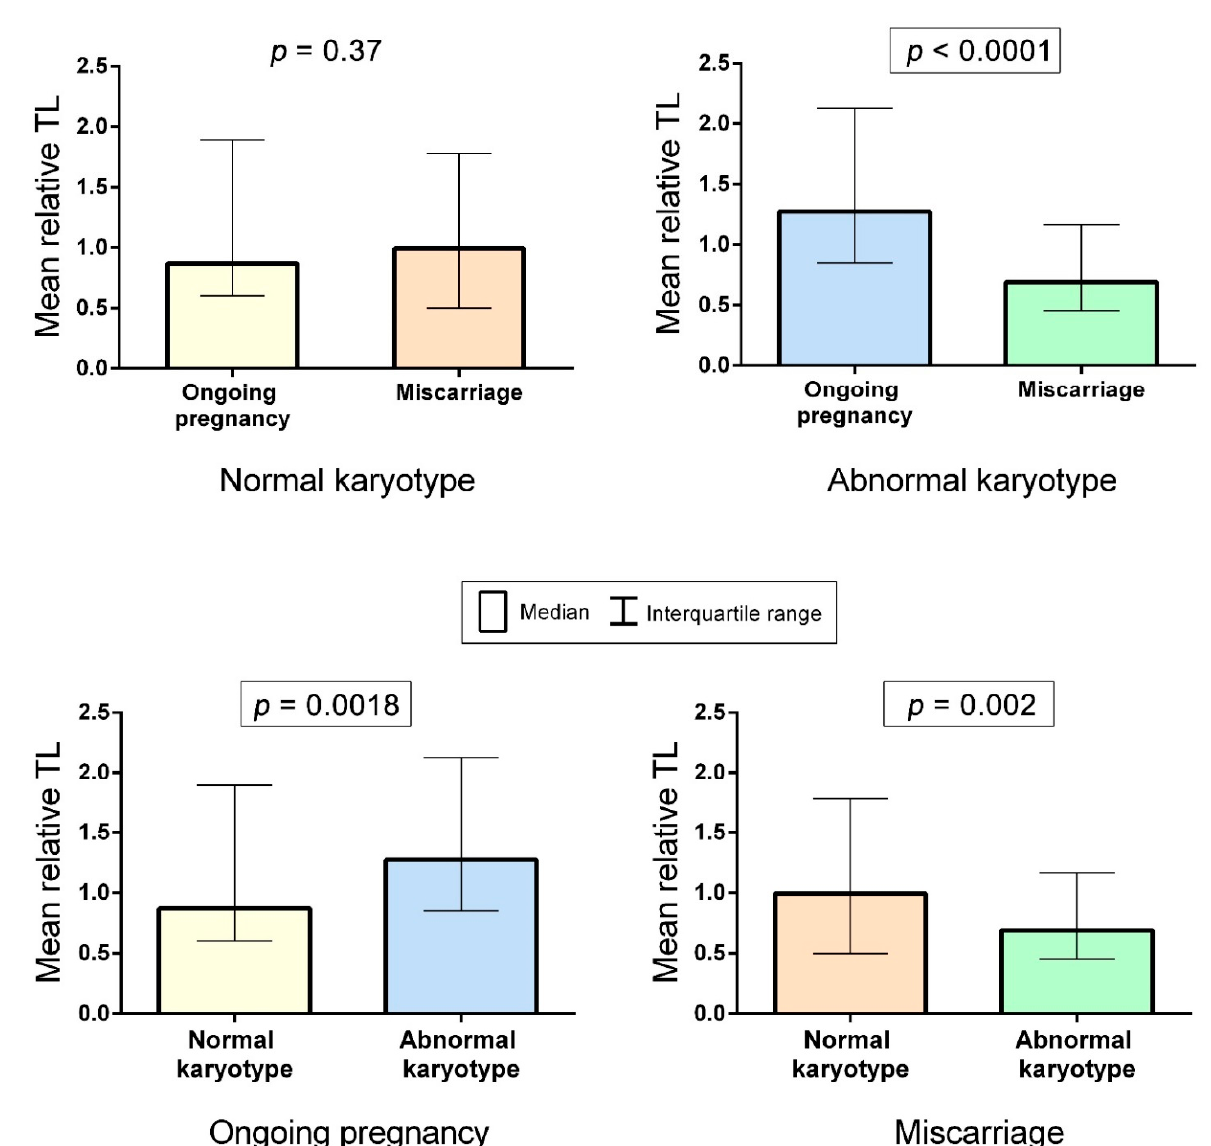
Figure 4. Mean relative telomere lengths (TLs) in metaphase chromosomes from chorionic cytotrophoblast in karyotypically normal and abnormal miscarriages and ongoing pregnancies. The comparisons showing significant difference (the Mann–Whitney U test) are framed.